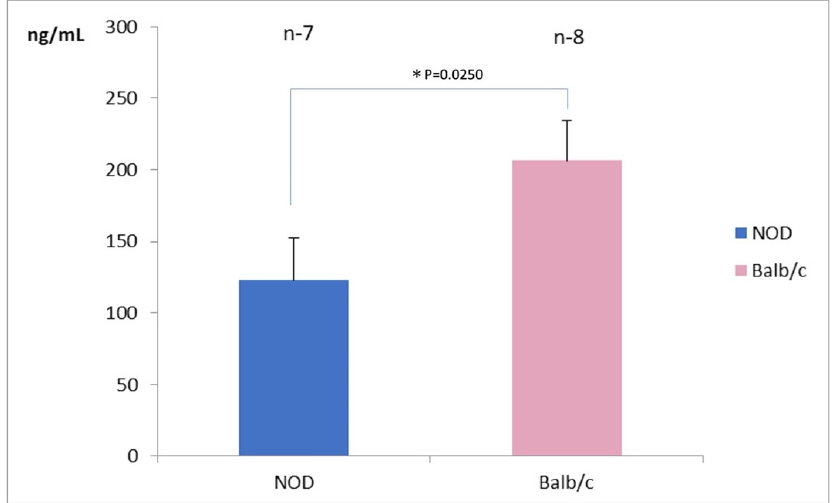
Figure 2. Comparison of tear lactoferrin concentrations between NOD and the Balb/c mice. Note the significantly lower tear lactoferrin concentrations in the NOD mice compared to the WT mouse ( p = 0.025). * represents p < 0.05.